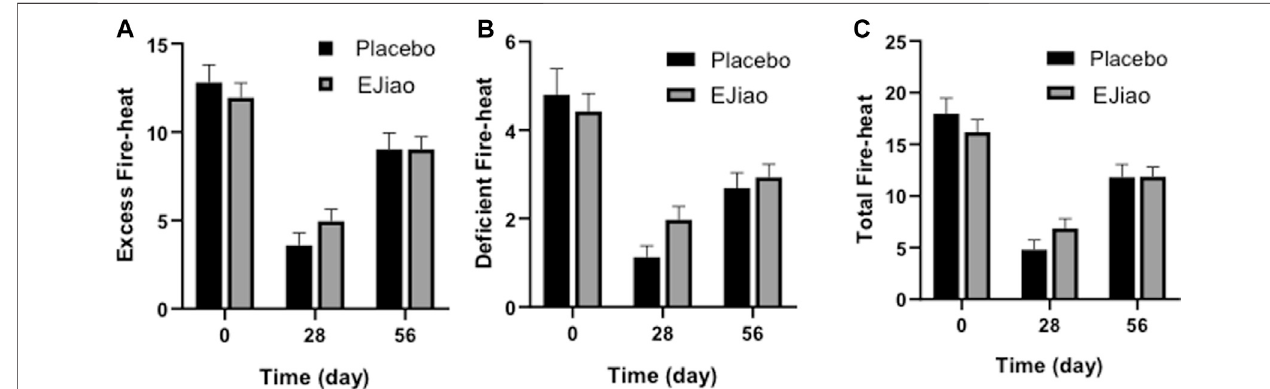
FIGURE 4 | fi re – heat syndrome scores of the placebo and Ejiao groups were evaluated before and 4 and 8 weeks after treatment. Syndrome score for total symptom item of excess fi re – heat (A) , de fi cient fi re – heat (B) , and total fi re – heat (C) are expressed as mean ± standard deviation.